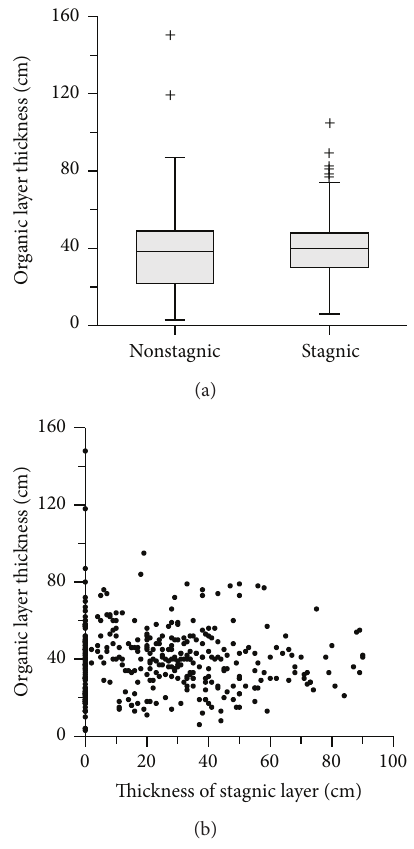
Figure 2: (a) Boxplots of organic layer thickness for soils with and without stagnic properties based on collected data set. (b) Scatter plot relating stagnic and organic layer thickness based on collected data